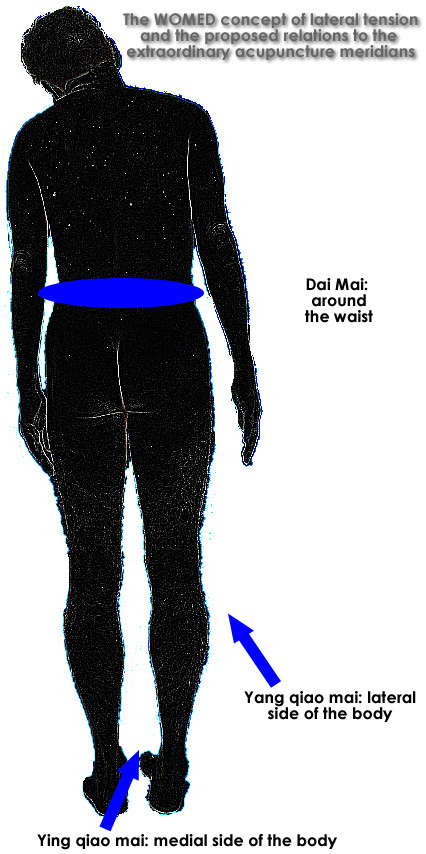
Schematic representation of the "WOMED concept of lateral tension". The body is found in an arch-like position which includes foot inversion, eccentric muscle position of the shank, calf and hip, as well as head falling to the side (based on [15]).